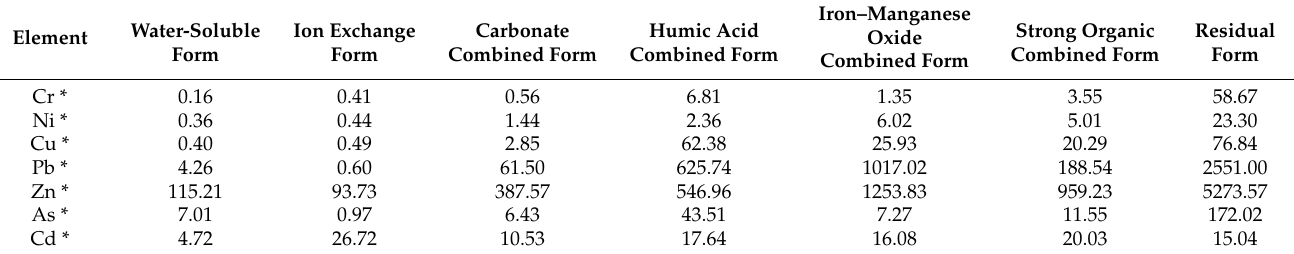
Table 4. Contents of different forms of heavy metals in soil around Dachang mining area.